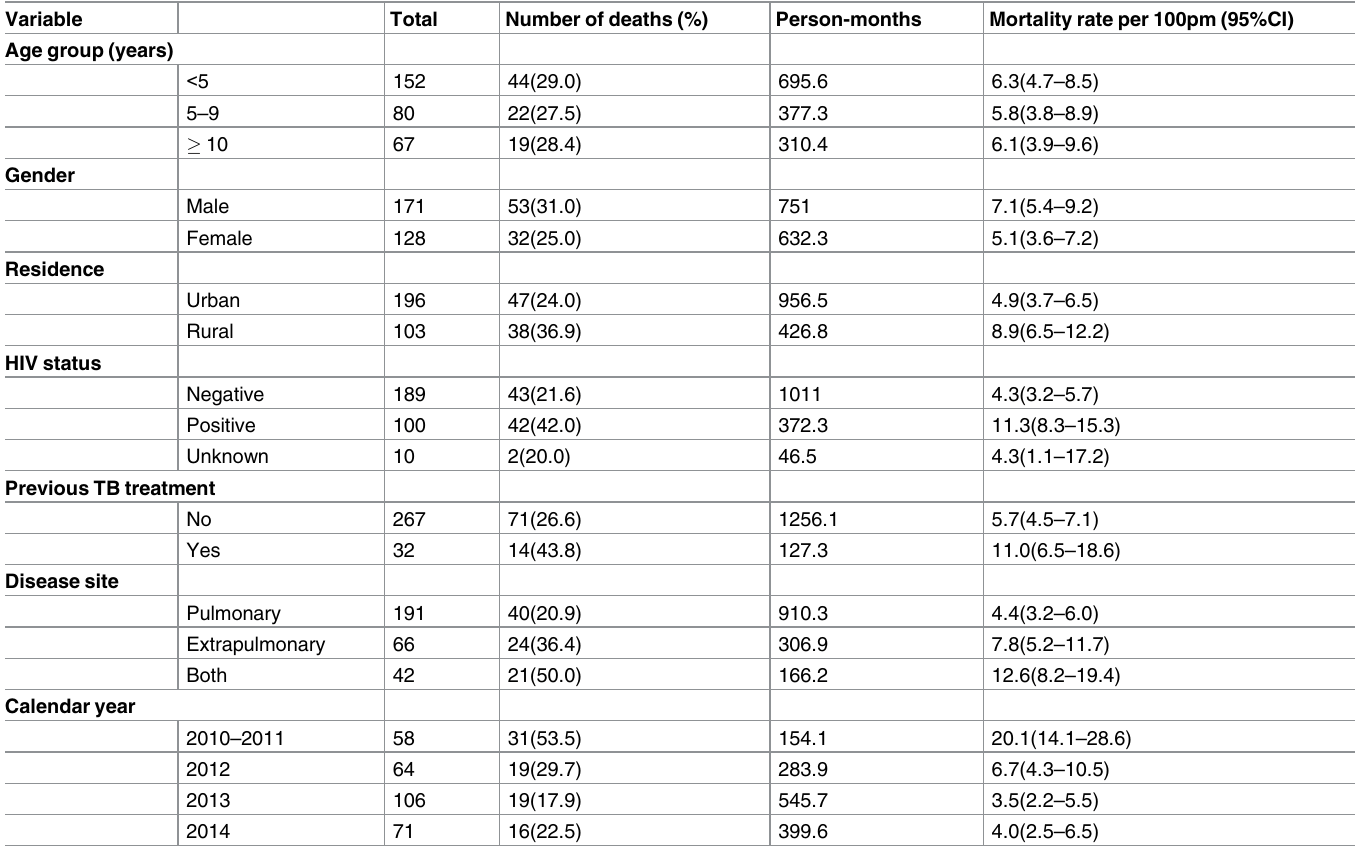
Table 1. Description of study cohort and mortality rates across explanatory variables, TB clinic, Aminu Kano Teaching Hospital, Kano, Nigeria.